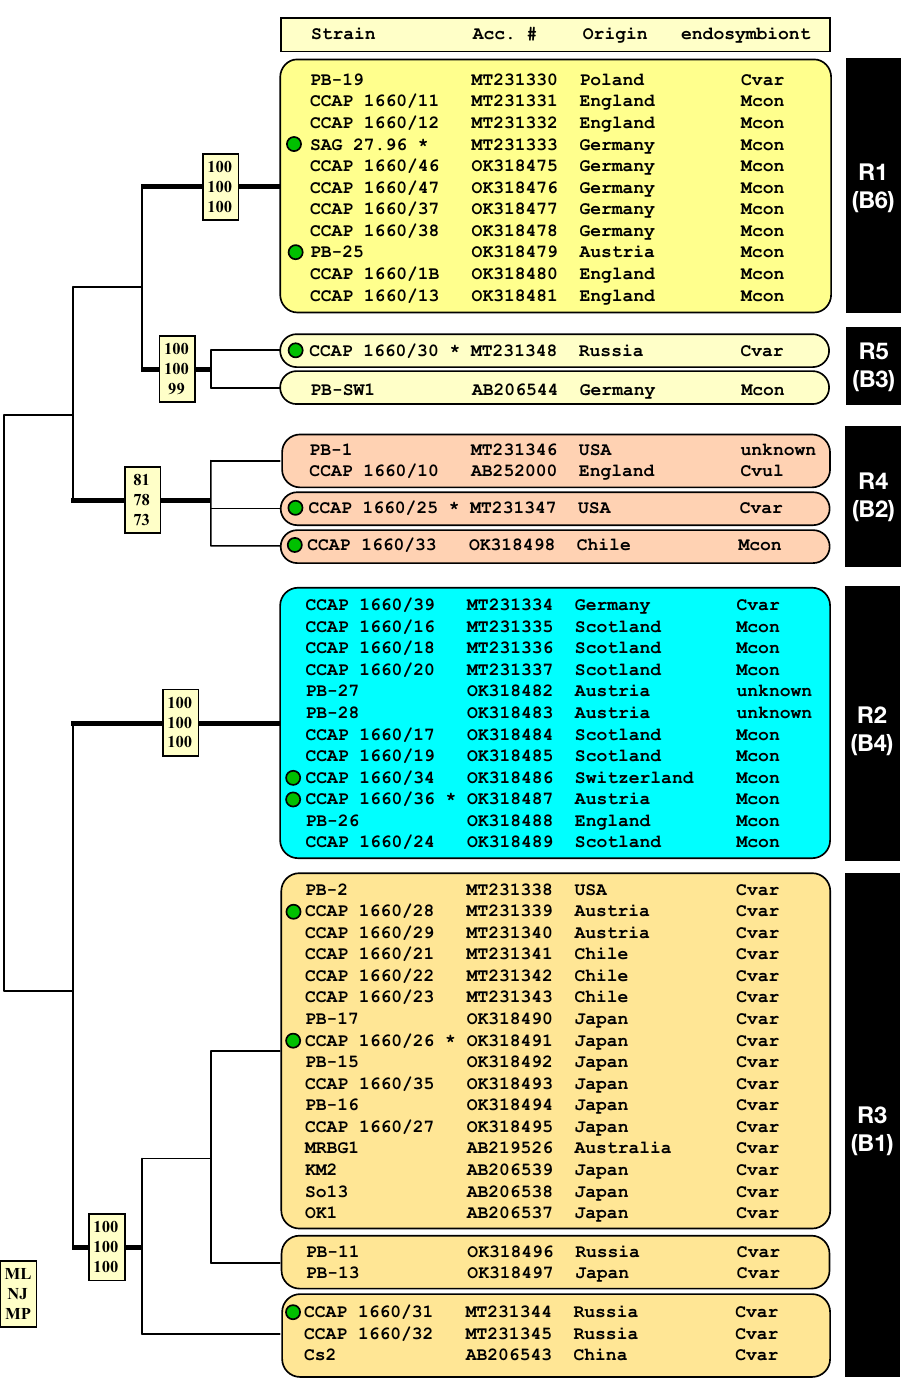
Figure 2. Molecular phylogeny of the Paramecium bursaria species complex based on SSU and ITS rDNA sequence comparisons. The phylogenetic tree shown was inferred using the maximum likelihood method based on the datasets (2197 aligned positions of 19 taxa) using the computer program PAUP 4.0a169. For the analyses, the best model was calculated by PAUP 4.0a169. The setting of the best model was given as follows: TVM + I (base frequencies: A 0.2983, C 0.1840, G 0.2271, T 0.2906; rate matrix A–C 2.6501, A–G 8.6851, A–U 5.3270, C–G 0.91732, C–U 8.6851, G–U 1.0000) with the proportion of invariable sites (I = 0.9544). The branches in bold are highly supported in all bootstrap analyses (bootstrap values > 50% calculated with PAUP using the maximum likelihood, neighbour—joining, and maximum parsimony). The clades are named after the syngens (color ‐ coded) proposed by Greczek ‐ Stachura et al. 10 and Bomford 9 in brackets. The accession numbers are given after the strain numbers. The endosymbiotic green algae identified are highlighted (Mcon— Micractinium conductrix , Cvar— Chlorella variabilis and Cvul— Chlorella vulgaris ) after the origin of the P. bursaria strains. The reference strain of each syngen is marked with an asterisk. The strains used for morphological comparisons are marked with a green dot next to the strain